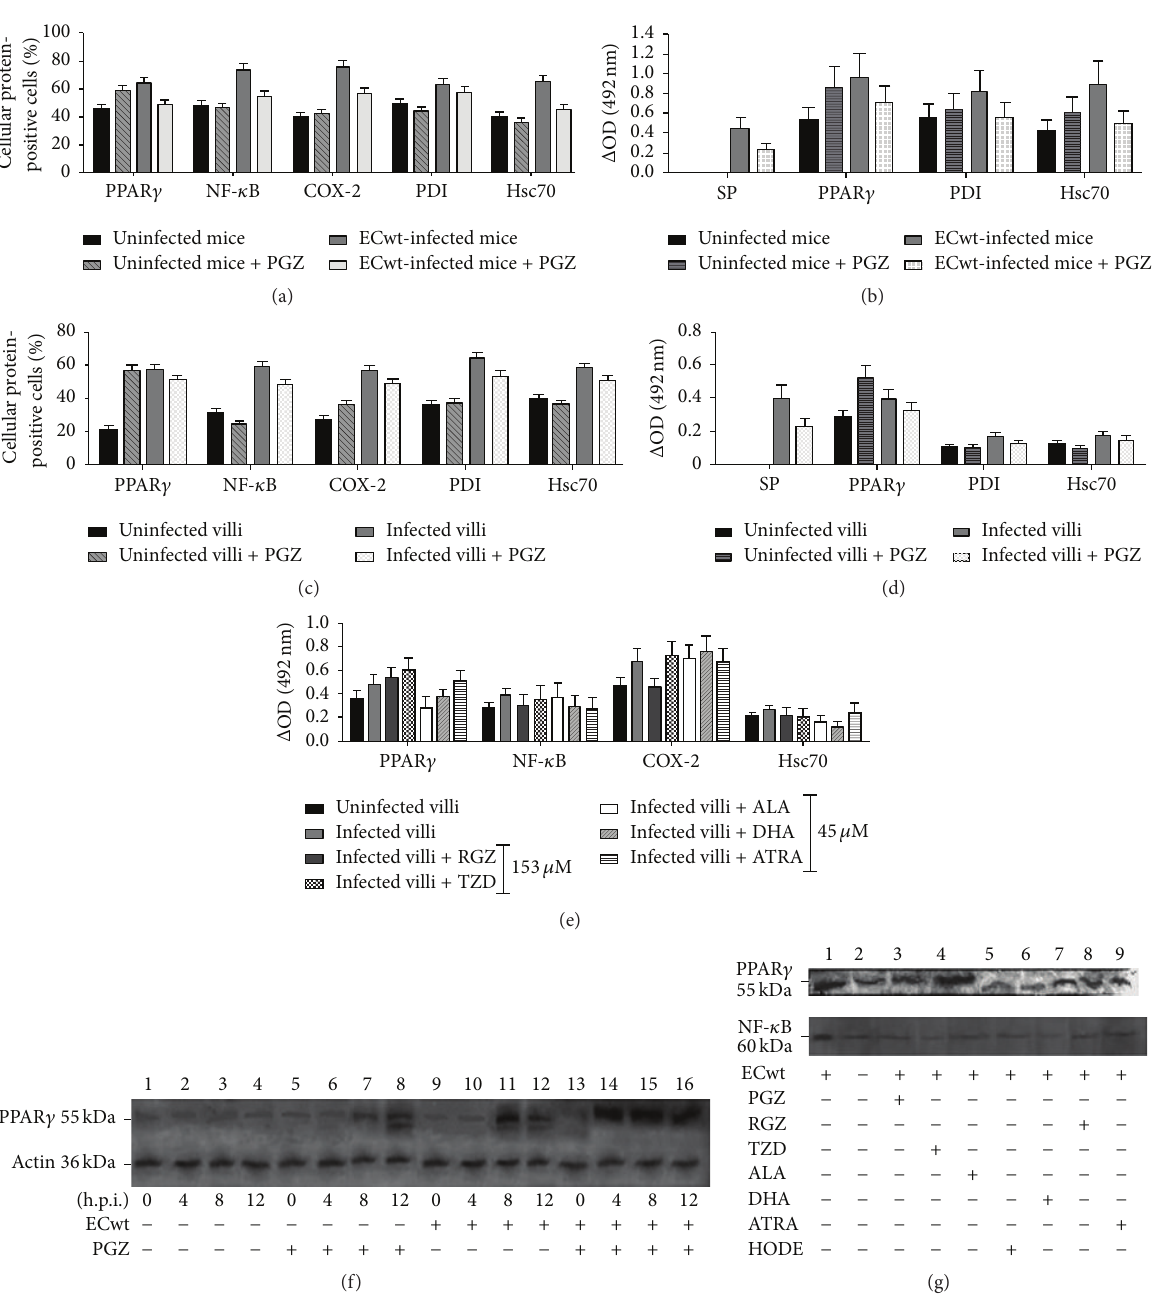
Figure 3: Expression of cellular proteins in villus cells from in vivo and in vitro ECwt-infected villi after treatment with PGZ. (a) Villi isolated from ECwt-infected mice ( 𝑛 = 3 per experiment) treated or not with PGZ were processed for immunofluorescence analysis using the primary antibodies against the indicated cellular proteins. Data are presented as mean percentage of villus cells being positive to the indicated proteins. (b) Villi isolated from ECwt-infected mice ( 𝑛 = 3 per experiment) treated or not with PGZ during the period 12 to 48h.p.i. were lysed and analyzed by capture ELISA using detecting antibodies against the indicated proteins. Data are shown as mean values through the indicated period. (c) Villi isolated from mice were infected in vitro with ECwt and then treated or not with PGZ before being subjected to immunofluorescence analysis as indicated in (a). (d) Villi isolated from mice were infected in vitro with ECwt and treated or not with PGZ before being analyzed by ELISA as indicated in (b). (e) Villi isolated from mice were infected in vitro with ECwt, treated or not as indicated in (e), and analyzed by ELISA as indicated in (b). Results are presented as mean ± SD from three independent experiments performed in duplicate. (f) Villi isolated from mice were infected or not in vitro with ECwt and treated or not with PGZ before Western blotting analysis of villus lysates for the expression of PPAR 𝛾 . (g) Villi isolated from mice were infected or not in vitro with ECwt and treated or not with RGZ, TZD, ALA, DHA, and ATRA before Western blotting analysis using anti-PPAR 𝛾 and anti-NF- 𝜅 B